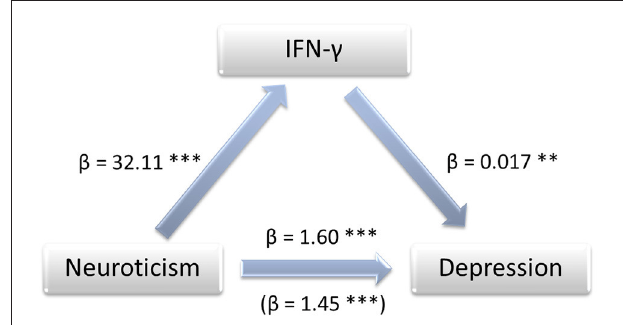
FIGURE 1 | Mediation model showing the impact of IFN- γ on the association between neuroticism and depression. Annotations: β , standardized coefficient of regression, ** p < 0.01, *** p <